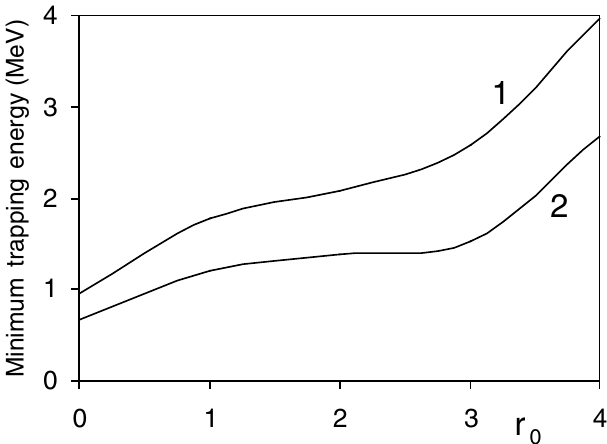
FIG. 6. The minimum trapping energy (in MeVs) depending on the initial normalized radial position r verse momentum is zero, (cid:31) (cid:2) 1 (peak intensity of I (1): a 0 laser wavelength of & 10 18 W = cm 2